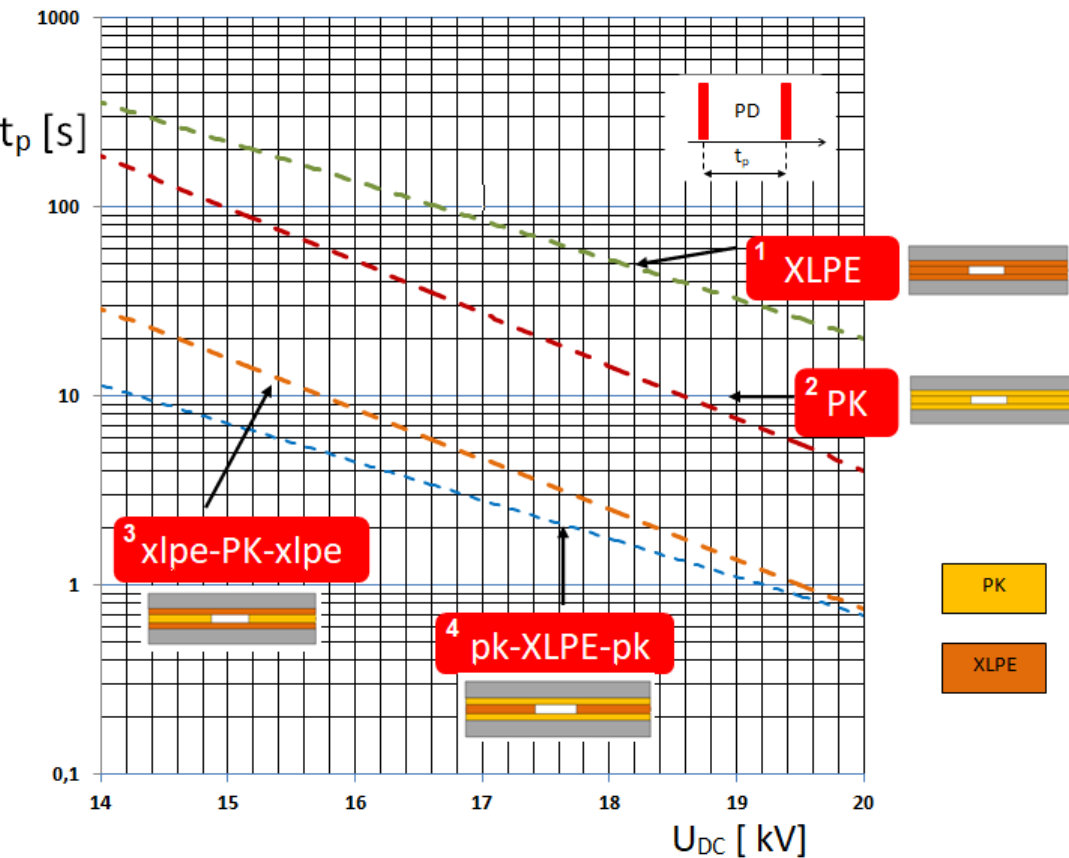
Figure 9. The relationship of time t p between consecutive PD pulses versus applied DC voltage U DC for various specimen configurations.